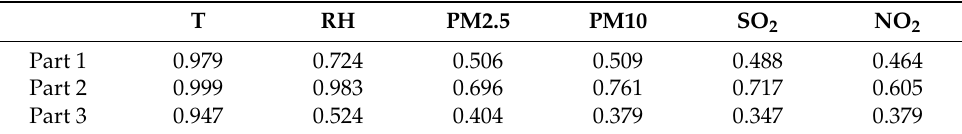
Table 4. The result of maximal information coefficient (MIC). T